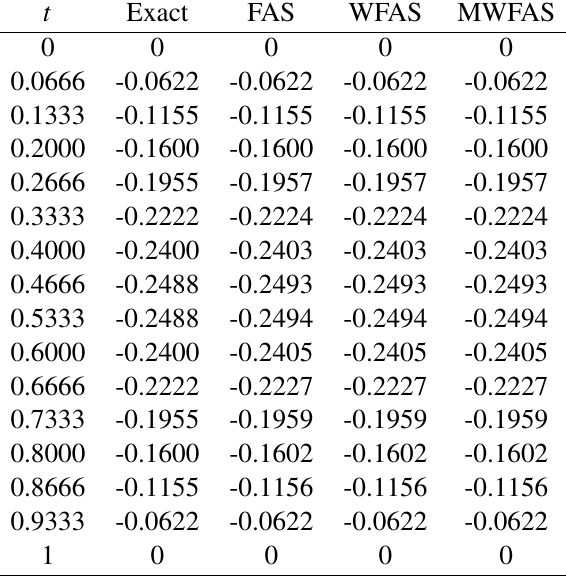
Table 7 Numerical results of test problem 5.4, for N = 16 .